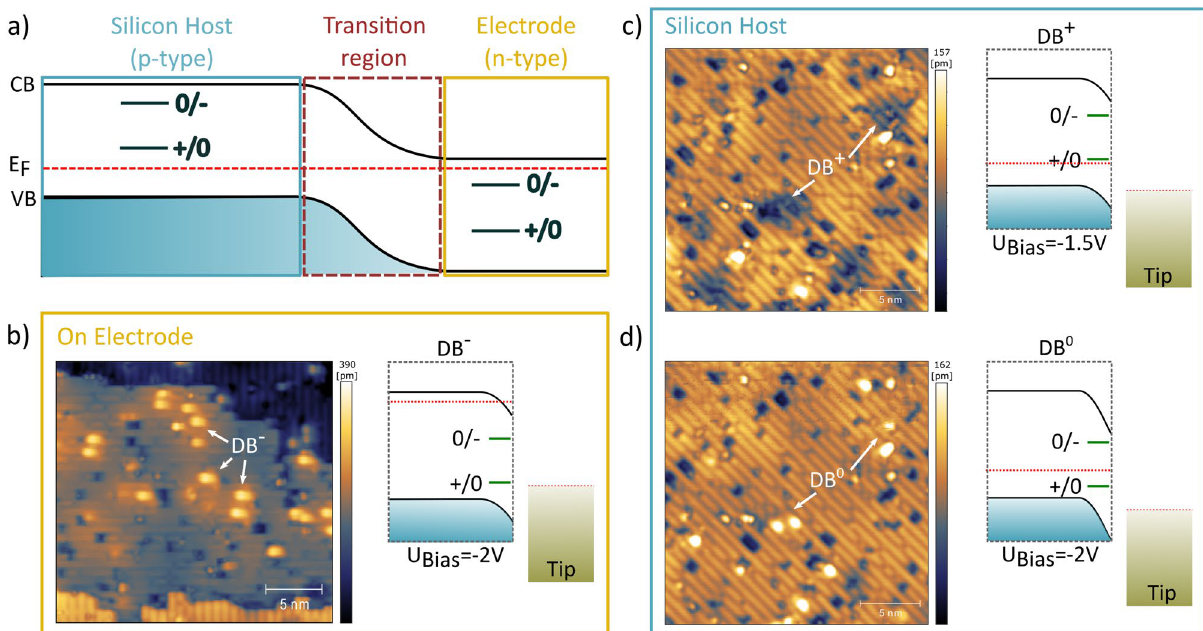
Figure 4. Controlling the charge state of a dangling bond: ( a ) schematic illustrating of the band structure depending on the position and the corresponding dopant concentration in the transition region. The position of the sample Fermi level with respect to the DB charge transition level determines their charge state. ( b ) STM image of the occupied states obtained on top of the electrodes (− 2 V) (position indicated as yellow rectangle in Fig. 3c) depicting a negatively charged DB. ( c ) STM image of the occupied states inside the gap region (position indicated as blue square in Fig. 3c) at − 1.5 V and ( d ) − 2 V, probing positive and neutral DB charge states, respectively. For each STM image the band structure and the effect of tip-induced band-banding is illustrated